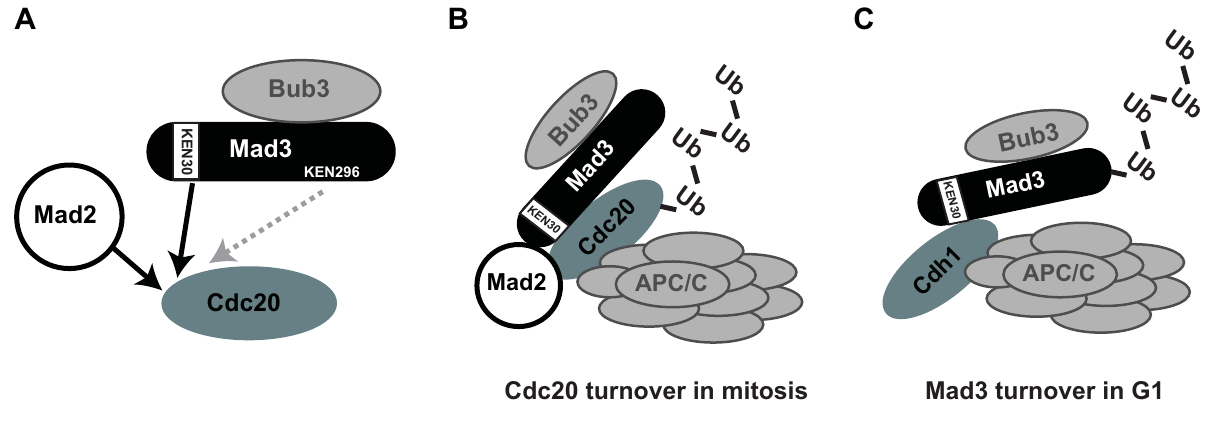
Figure 8. Models of Mad3p KEN box interactions. a) Mad3 KEN box interactions. Mad2p and Mad3-KEN30 are both required for stable Mad3p- Cdc20p binding. b) Cdc20p turnover in mitosis: this is dependent on Mad3-KEN30, and Mad2p, suggesting that this Mad3 KEN box acts ‘‘in trans’’ as a Cdc20p degron. c) Mad3p turnover in G1. Mad3p is degraded in a Mad3-KEN30, Cdh1, and APC/C dependent manner.